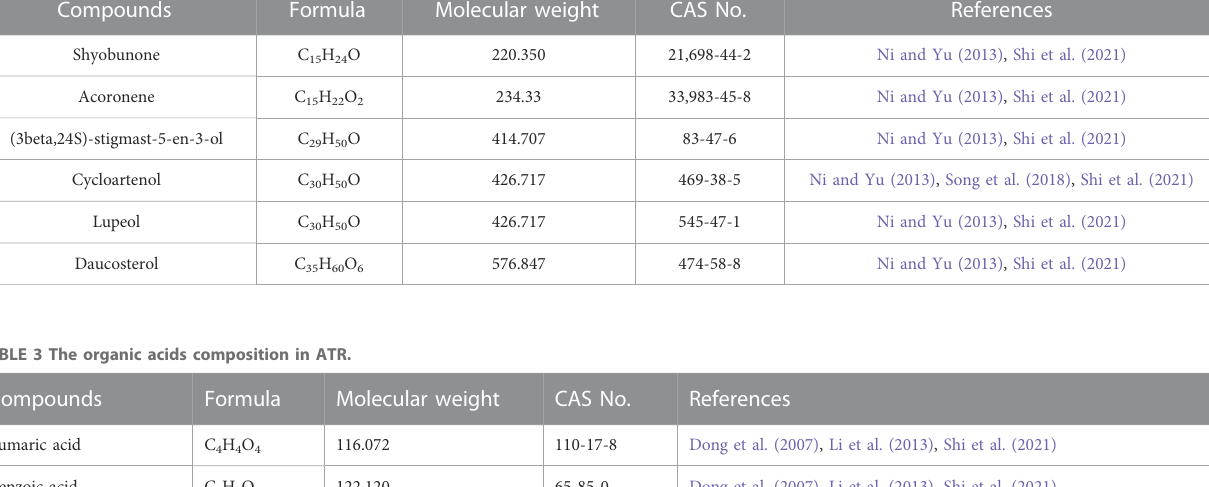
TABLE 2 The terpenoids composition in ATR. Compounds Formula Molecular weight CAS No.